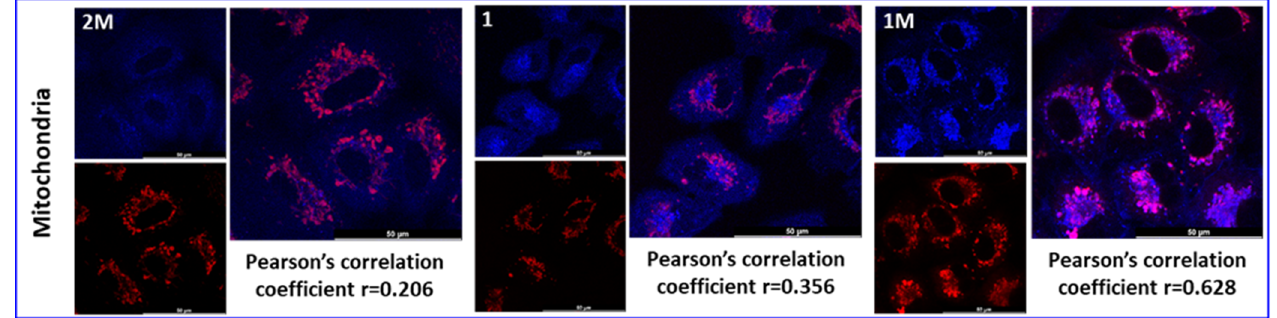
Figure 11. ( A ) Colocalisation of 2M , 1 , and 1M (blue, λ exc = 350 nm; λ em = 420–500 nm) with LAMP1 (magenta) observed by confocal microscopy. Cells were treated with 10 µM of the respective compound for 90 min at 37 °C, fixed with PFA, and subsequently stained with anti LAMP1 antibody. ( B ) Colocalisation of 2M , 1 , and 1M (blue) with GM130 (magenta) was observed by confocal microscopy. Cells were treated with 10 µM of the respective compound for 90 min at 37 °C, fixed with PFA, and subsequently stained with anti GM130 antibody. Colocalisation is assessed by the Pearson correlation coefficient. Analysis was conducted using ImageJ software and the appropriate JACoP plugin [53].